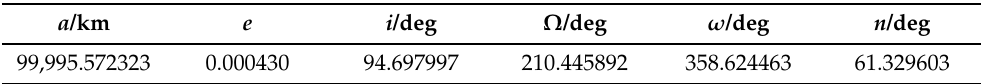
Table 5. Elements of the nominal orbit of TQO